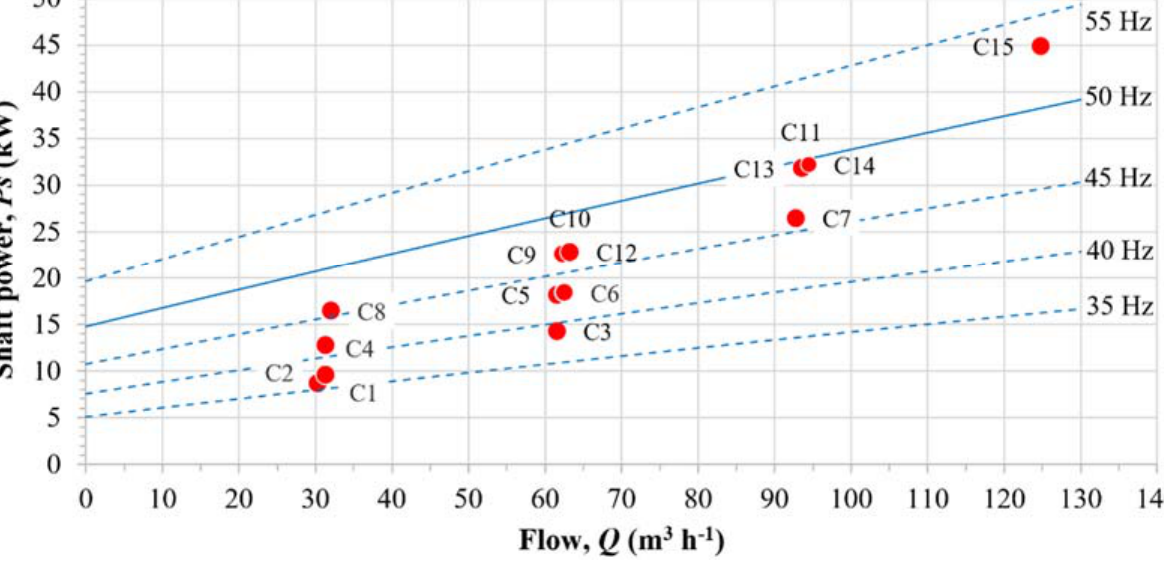
Figure 9. Power curves on the centrifugal pump shaft at different operating frequencies and 15 operating points corresponding to the minimum power values on the pump shaft for each combination of irrigation sectors C1 to C15 (Table 9).